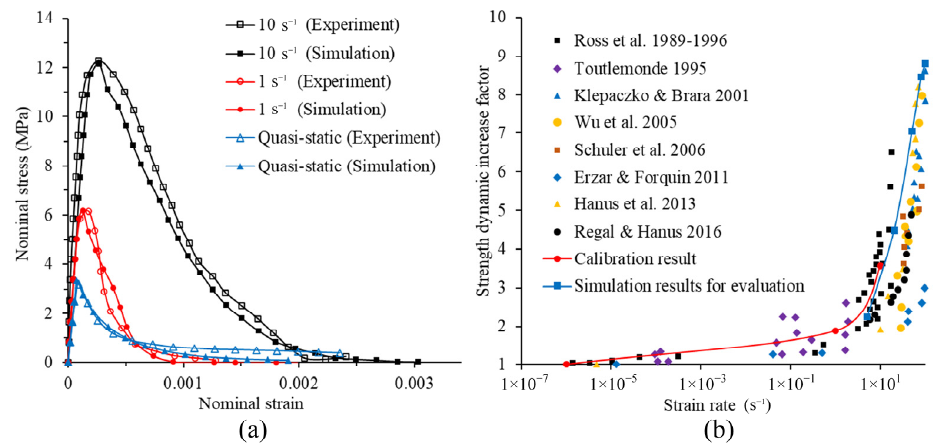
Figure 4. Model calibration and evaluation of DIF with experimental results: ( a ) stress–strain curves of simulations and experiments [2]; ( b ) DIF of tension strength for simulations and experiments [42].